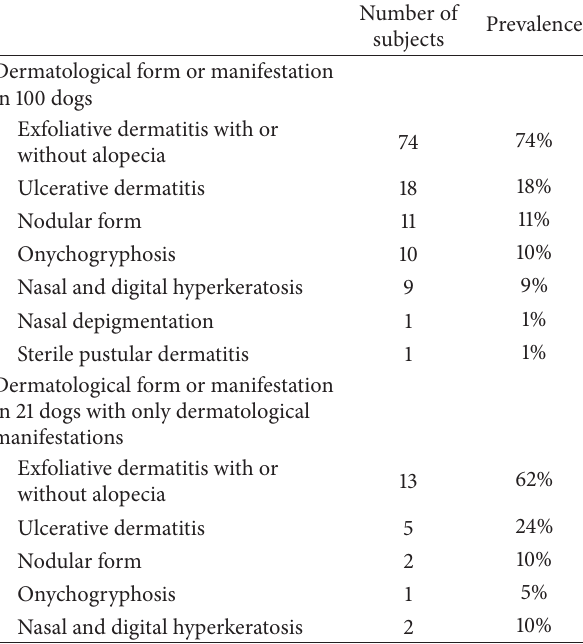
Table 1: Distribution of dermatological manifestation of CanL in all 100 dogs and in 21 dogs in the group with only dermatological manifestations of CanL and no identifiable systemic